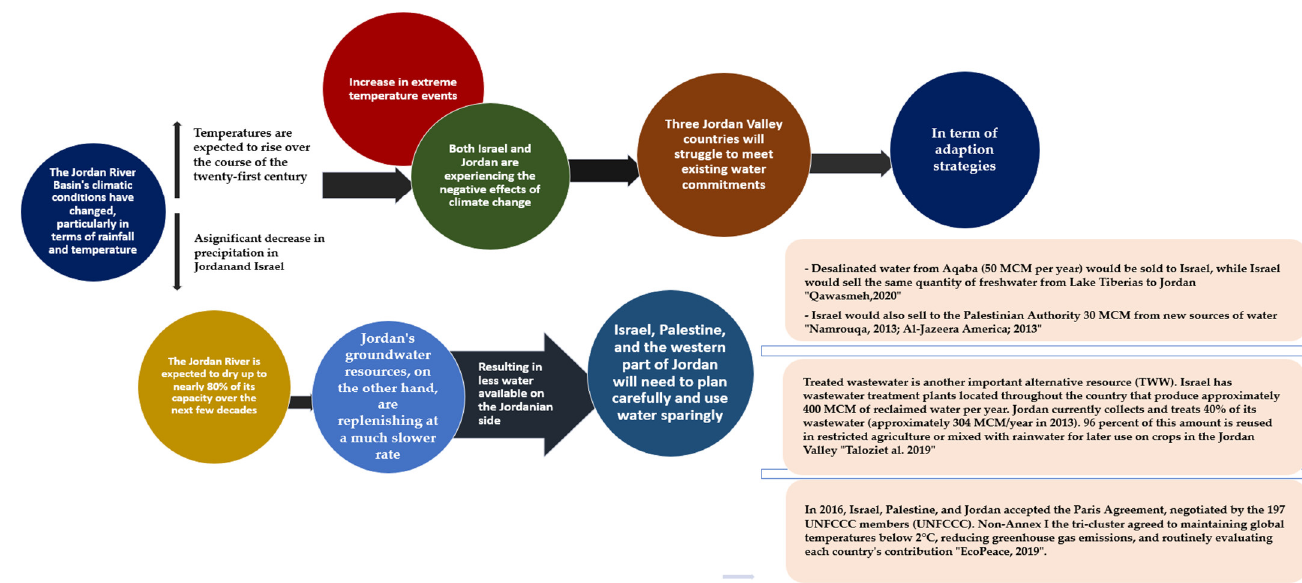
Figure 4. Selected aspects related to sub-regional water-related climate change impacts and adaption strategies noted in the region (Jordan River Basin) [17,45,51,54,55]. Projections show that by 2030, Palestinians living in this region may reach 7.2 million.